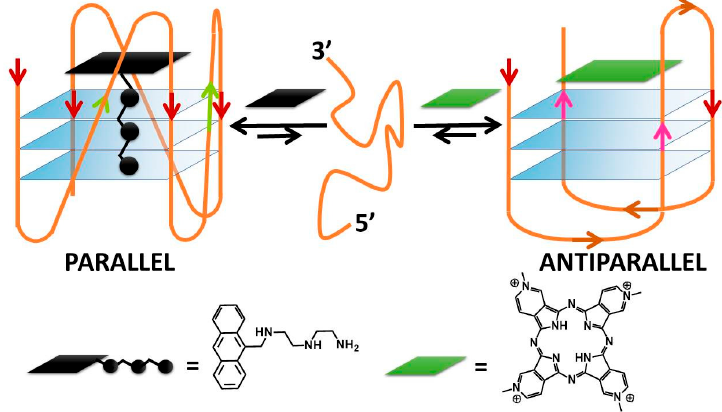
Figure 9. DNA conformational switching according to Rodriguez and co-workers [90].